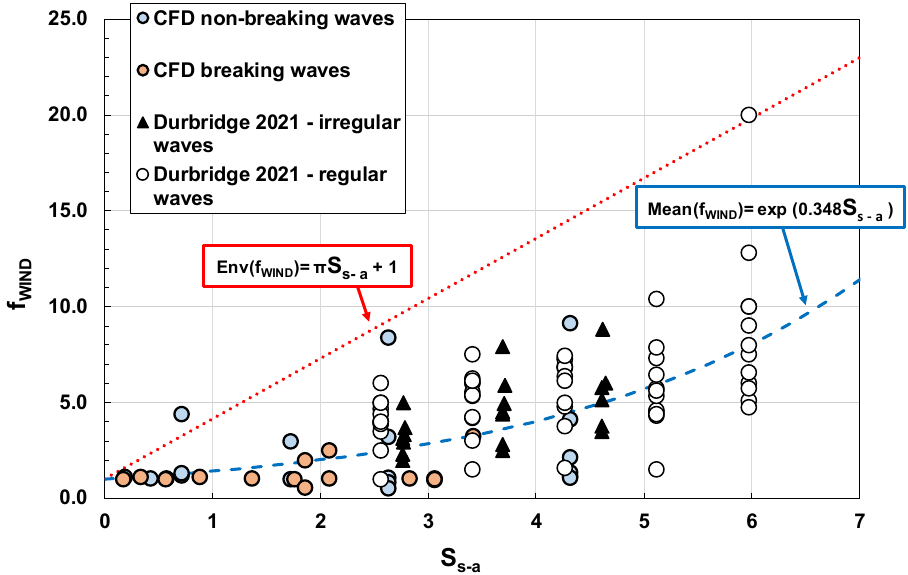
Figure 19. Comparison between numerical and literature [27] results.